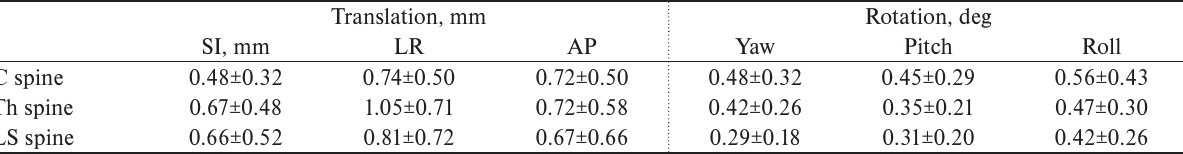
Table 3. Spine stability during SBRT treatment in the cervical (C), thoracic (Th) and lumbar-sacral (LS) regions of the